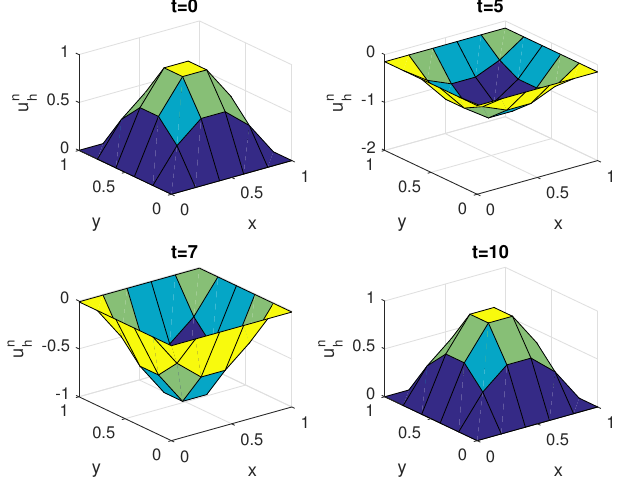
Figure 9. Numerical results of u n Experiment